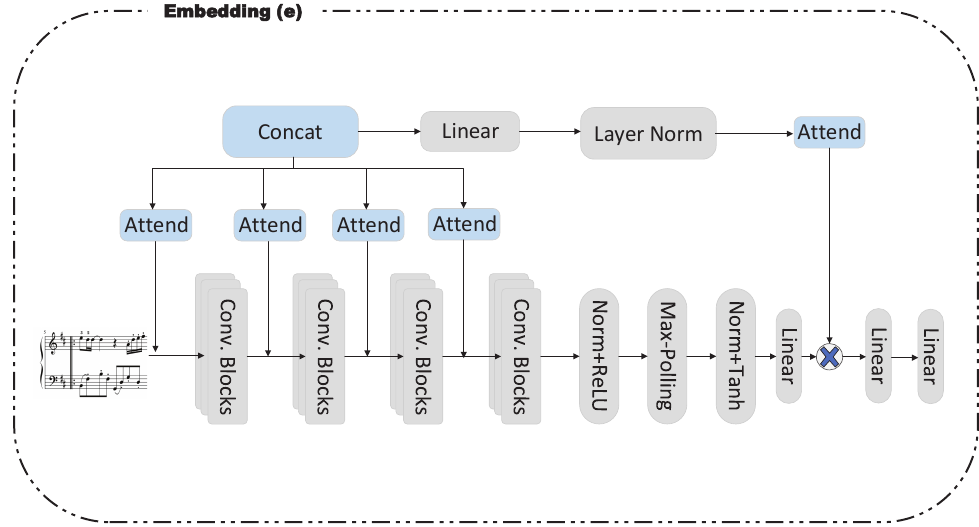
Figure 8. A design of spatial convolutional embedding module for three-dimensional sequential convolutional network.